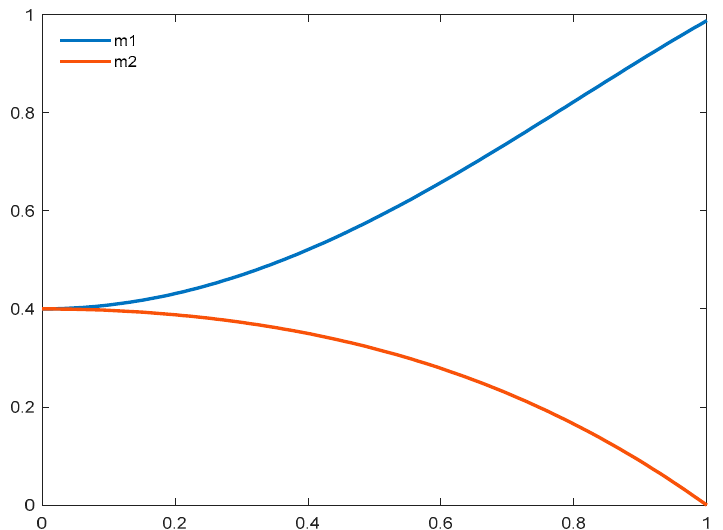
Figure 1. Adaptive coefficients for the g best solution (blue) and the p best signal (red) for exemplar generation (where x axis denotes a randomly generated value between 0 and 1, and y axis denotes the weight parameters, i.e., m 1 and m 1 defined in Equations (16) and (17)). Specifically, we prescribe a decreasing process to control the number of selected p best solutions for exemplar generation. It starts with three p best solutions being randomly selected for breeding, then eliminating one in every 25 iterations. As a result, four different cases are produced through the iterative process for p best selection, i.e., 3 for iterations [1, 25], 2 for iterations [25, 50], 1 for iterations [25, 75], and 0 for iterations [75, 100]. At the beginning of the search process, the higher number of selected p best solutions aims optimal signal diversity and less similarity among the p best solutions. This can further selected p best solutions through the iterative process as well as the higher similarity among elicit solutions owing to a gradually converged population, the disturbance produced by breeding on g best becomes less significant as compared with that from the early